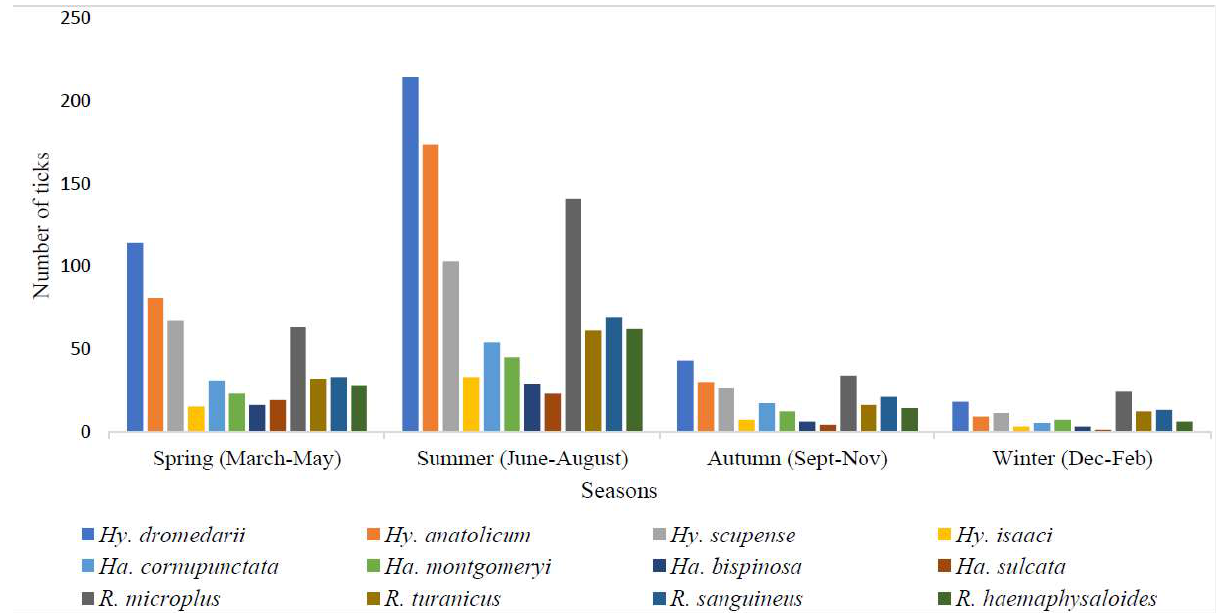
Figure 4. Seasonal abundance of the collected ixodid ticks in the study